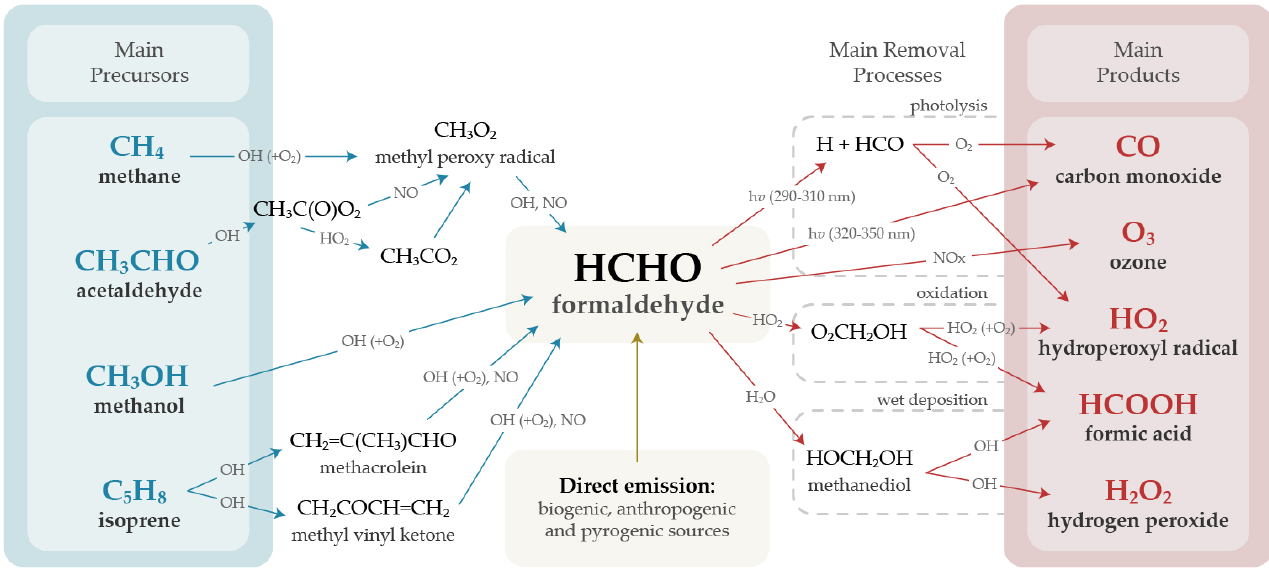
Figure 1. Overview of the main production and removal reactions of atmospheric